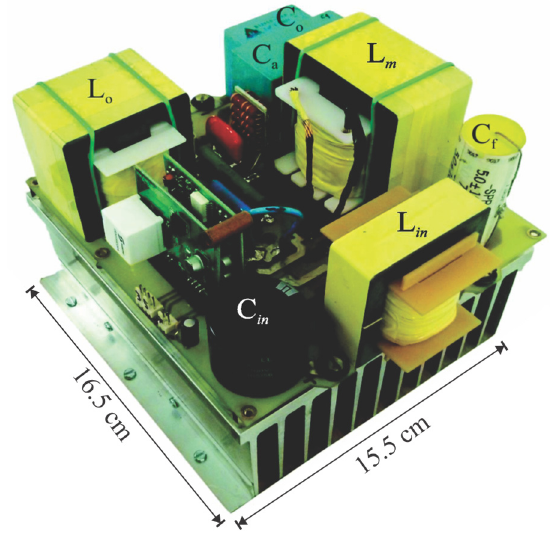
Figure 8. Zeta converter prototype. Table 5. Electrical specifications of the PV array @ S = 800 W/m 2 and T = 47 °C (NOTC).